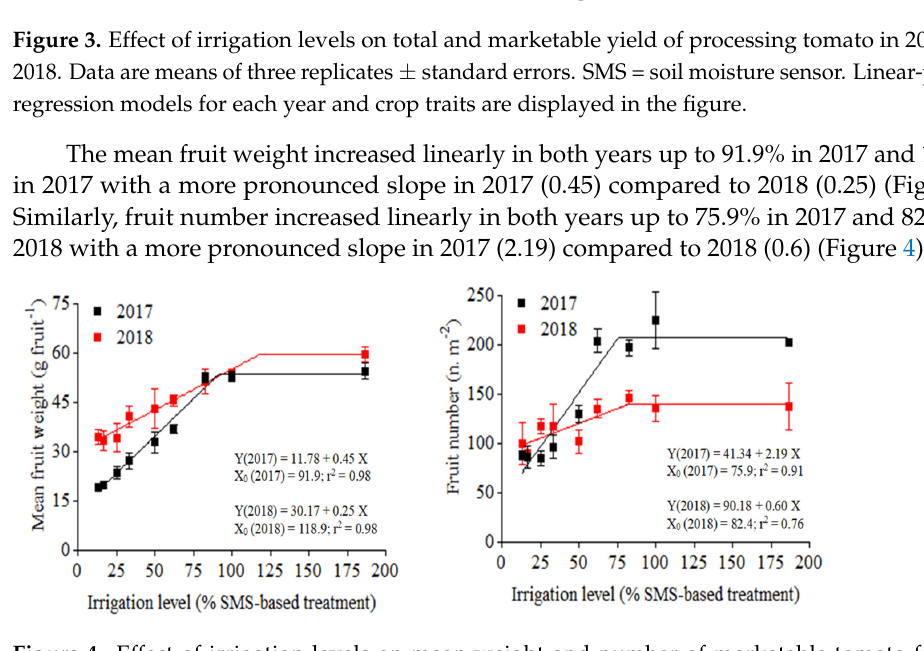
Figure 3. E ff ect of irrigation levels on total and marketable yield of processing tomato in 2017 and 2018. Data are means of three replicates ± standard errors. SMS = soil moisture sensor. Linear-plat- eau regression models for each year and crop traits are displayed in the fi gure.